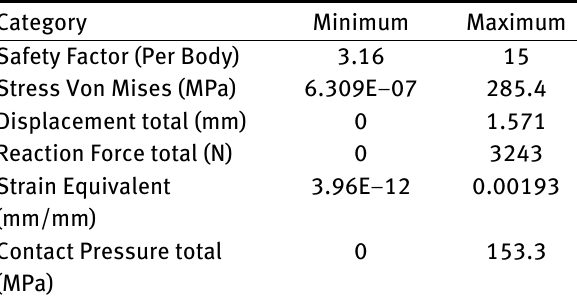
Table 5: Result summary of 0.15 m by 4500 N loaded force Category